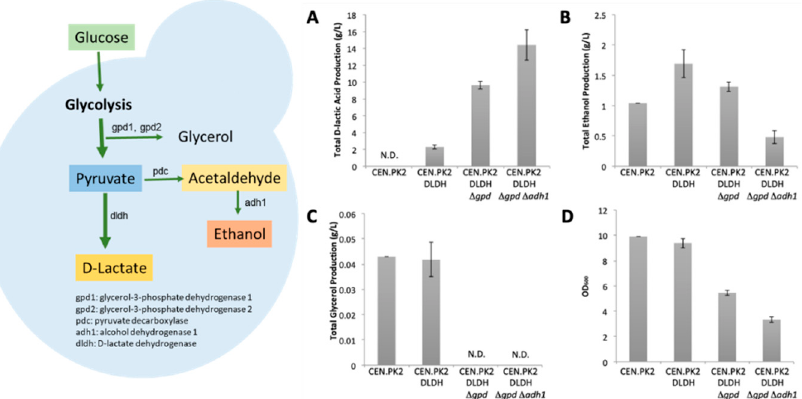
Figure 1. Metabolic and growth profiles of engineered strains. ( A ) Production of D-lactic acid, ( B ) ethanol, ( C ) glycerol, and ( D ) growth profile of the engineered strains. The cultures were grown at 30 °C and 250 rpm in an orbital shaking incubator. Samples were taken after 3 days, and the supernatants were analyzed on HPLC to quantify the content of each metabolite (N.D. indicates that the metabolite was not detected). Data represent mean values of biological triplicates and error bars indicate standard deviations.